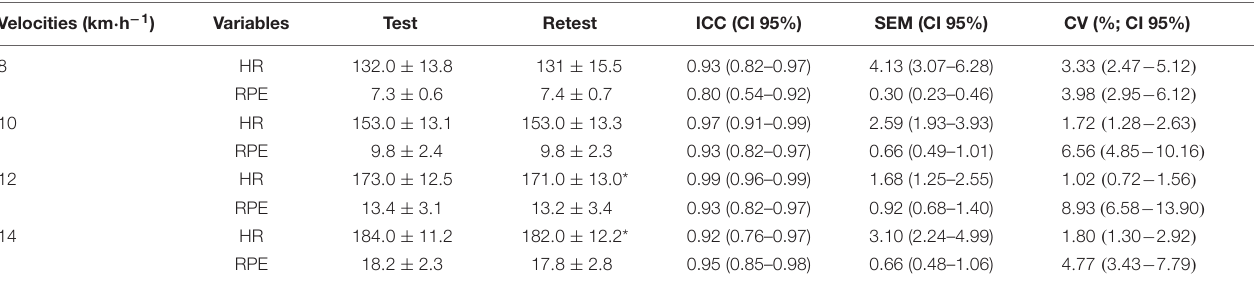
TABLE 5 | Reliability of the submaximal HR and RPE values obtained during the test to determine V peak _ TF for recreational runners (RR). Velocities (km · h − 1